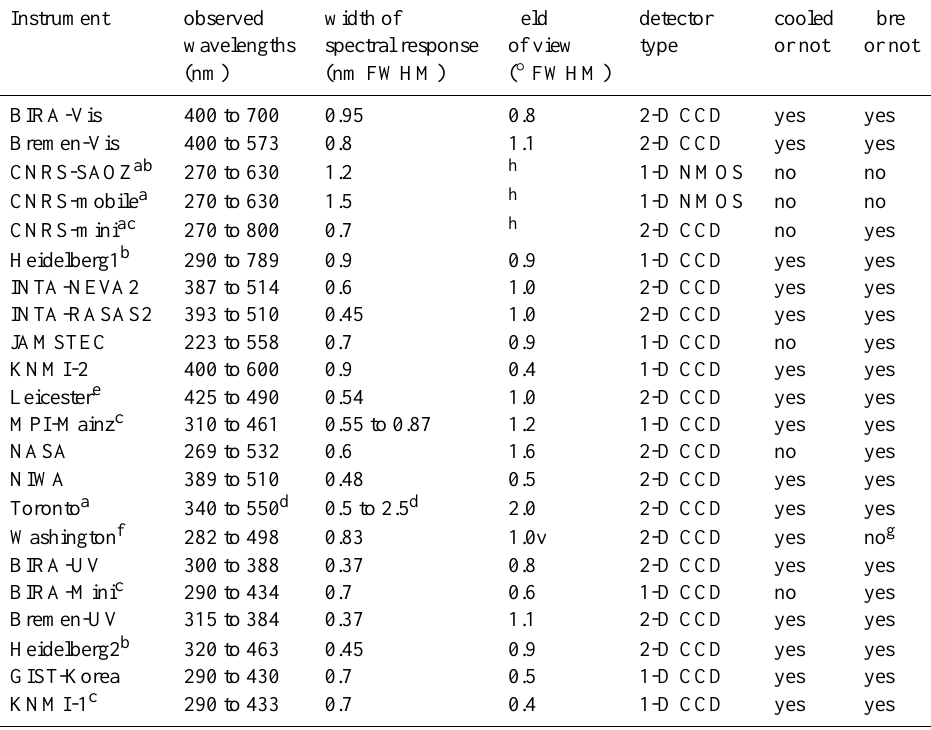
Table 1. Characteristics of the various spectrometers taking part in the intercomparison campaign. Locations were at the roof tops shown in Fig. 3 unless otherwise